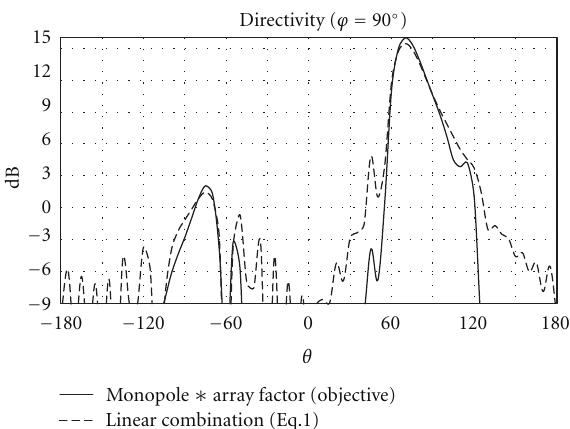
Figure 4: Comparison of the objective radiation pattern (radiation pattern of monopole x -array factor) with the linear combination of the radiation patterns of monopoles ( f = 5 . 6GHz).